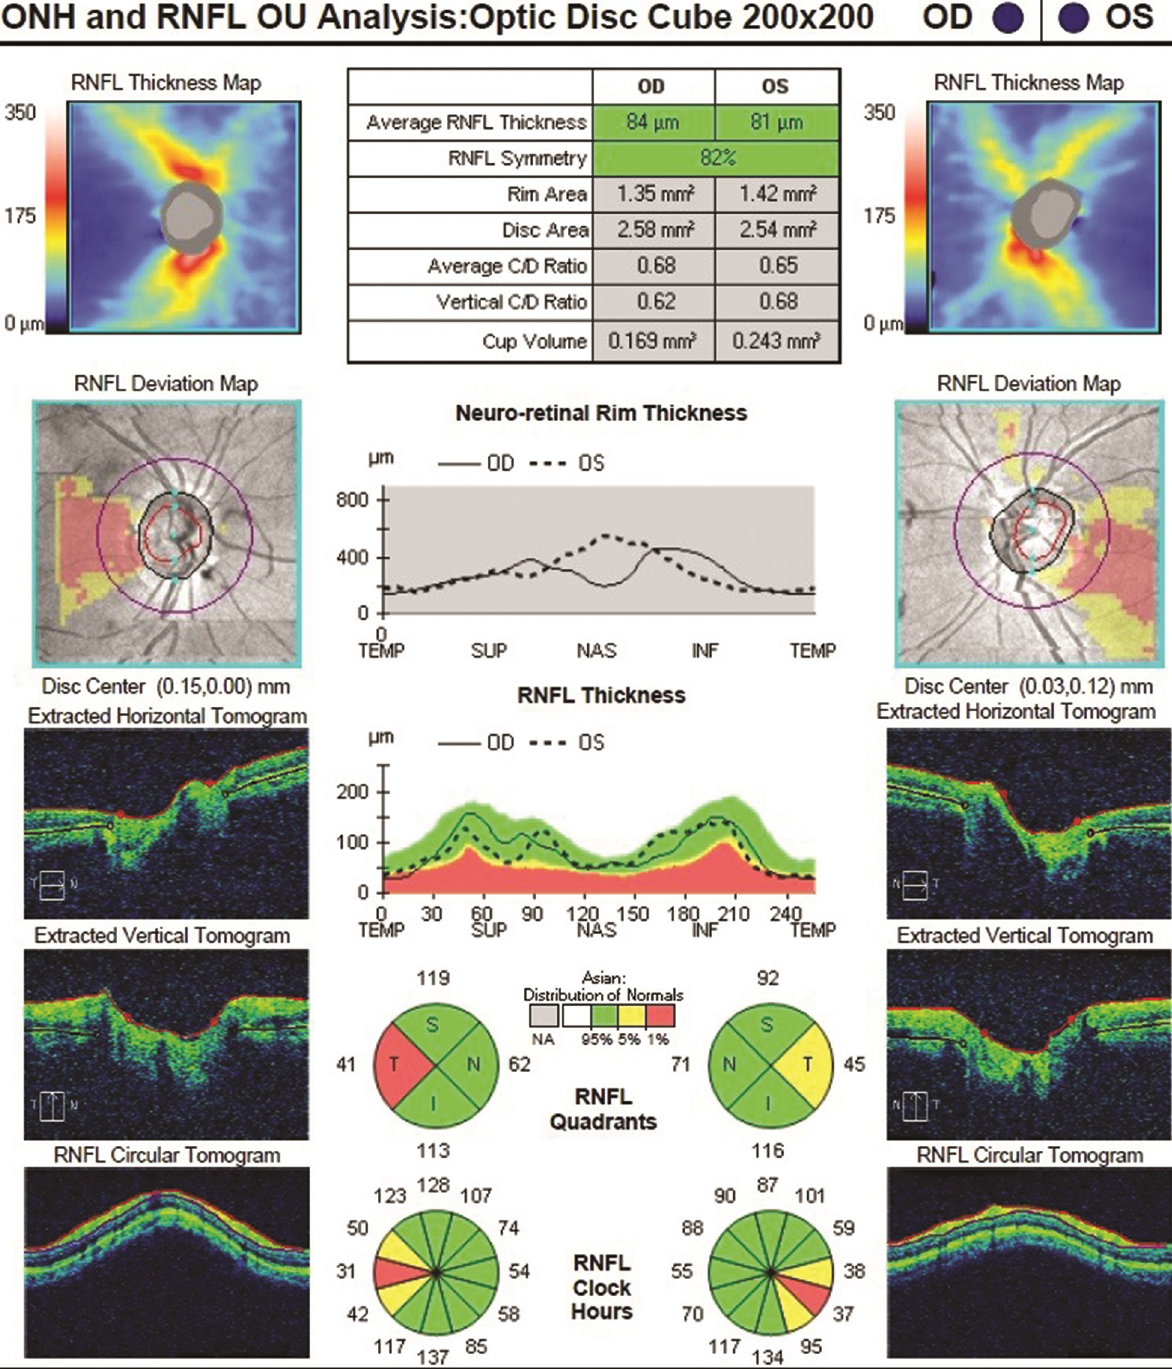
Fig 2. The Cirrus HD-OCT result of peripapillary RNFL thickness in a patient with AD. ONH: optic nerve head, OD: right eye, OS: left eye.